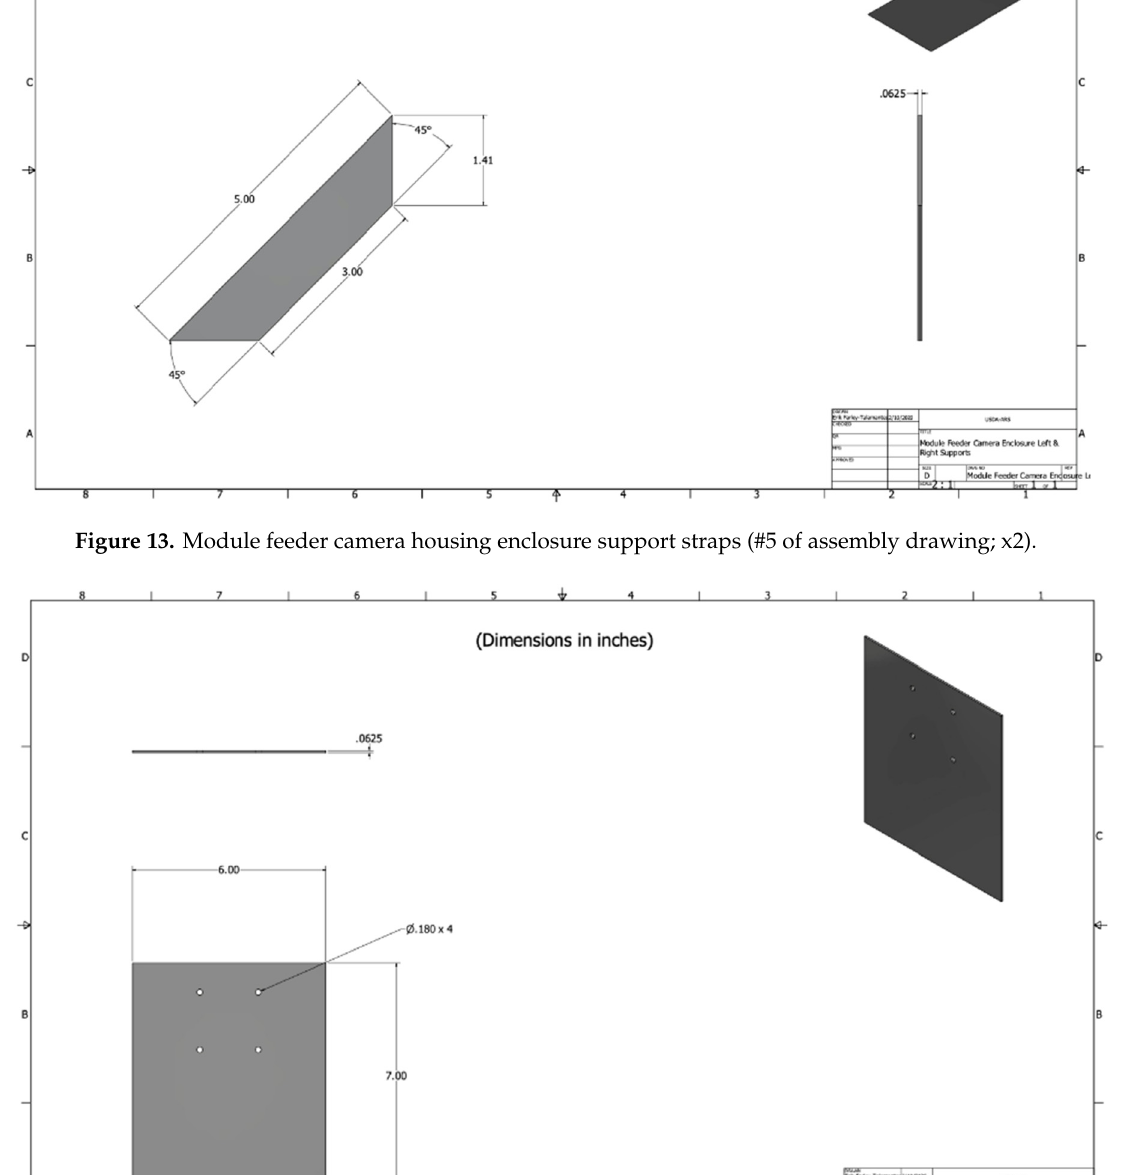
Table 1. Bill Of Materials (Available from Amazon.com).